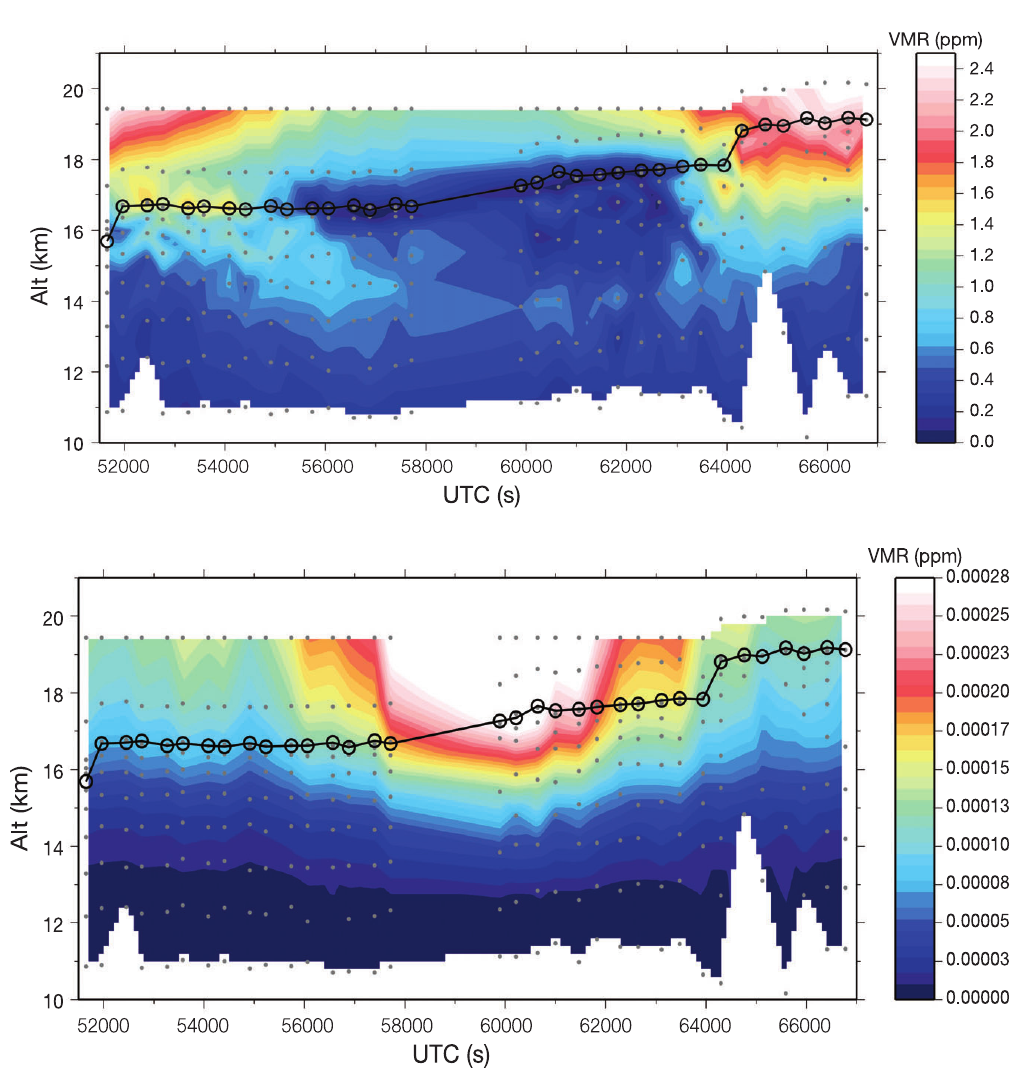
Fig. 16. Ozone ( upper panel ) and ClO ( lower panel ) VMR maps obtained from data acquired by SAFIRE-A during the 23.09.1999 scientifi c fl ight. Horizontal axis indicates fl ight time in seconds UTC, VMR units are ppmv. Aircraft fl ight altitude is superimposed on the